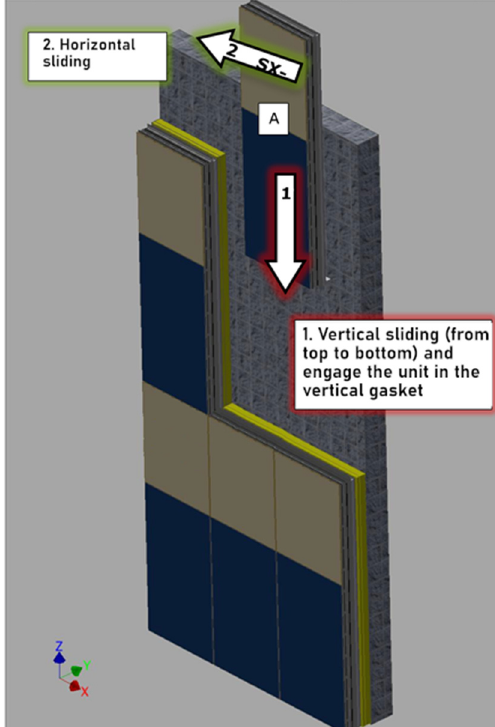
Figure 3. Connection between panels.